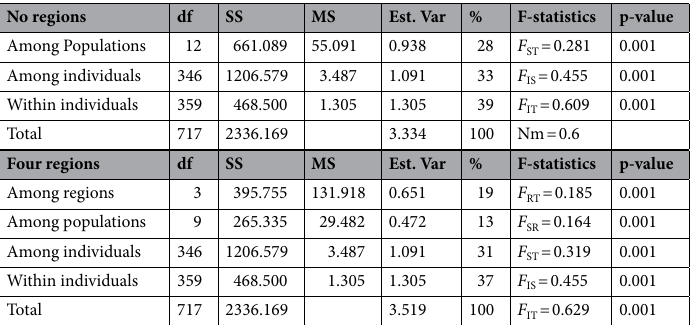
Table 3. Summary of AMOVA and F -statistics of Rhizophora mucronata for all populations and a hierarchical AMOVA considering four regions, namely East Africa (KEN and TAN), the Mozambique Channel (MOZ1 to MOZ6), the Seychelles (SEY) and as a fourth group the Aldabra Atoll and Madagascar (ALD1, ALD2, MAD1, MAD2). These four regions account for the largest variance of the Western Indian Ocean populations. Overall connectivity between populations is low with an estimated Nm below 1; df: degrees of freedom; SS: sum of squares; MS: mean of squares; % Est.Var.: estimated